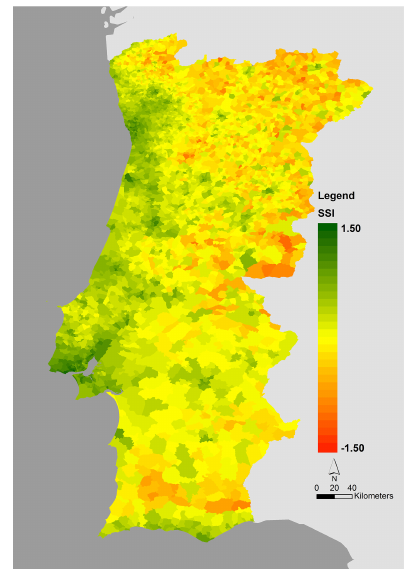
Figure 3. Flood social susceptibility index (SSI) for the continental Portuguese